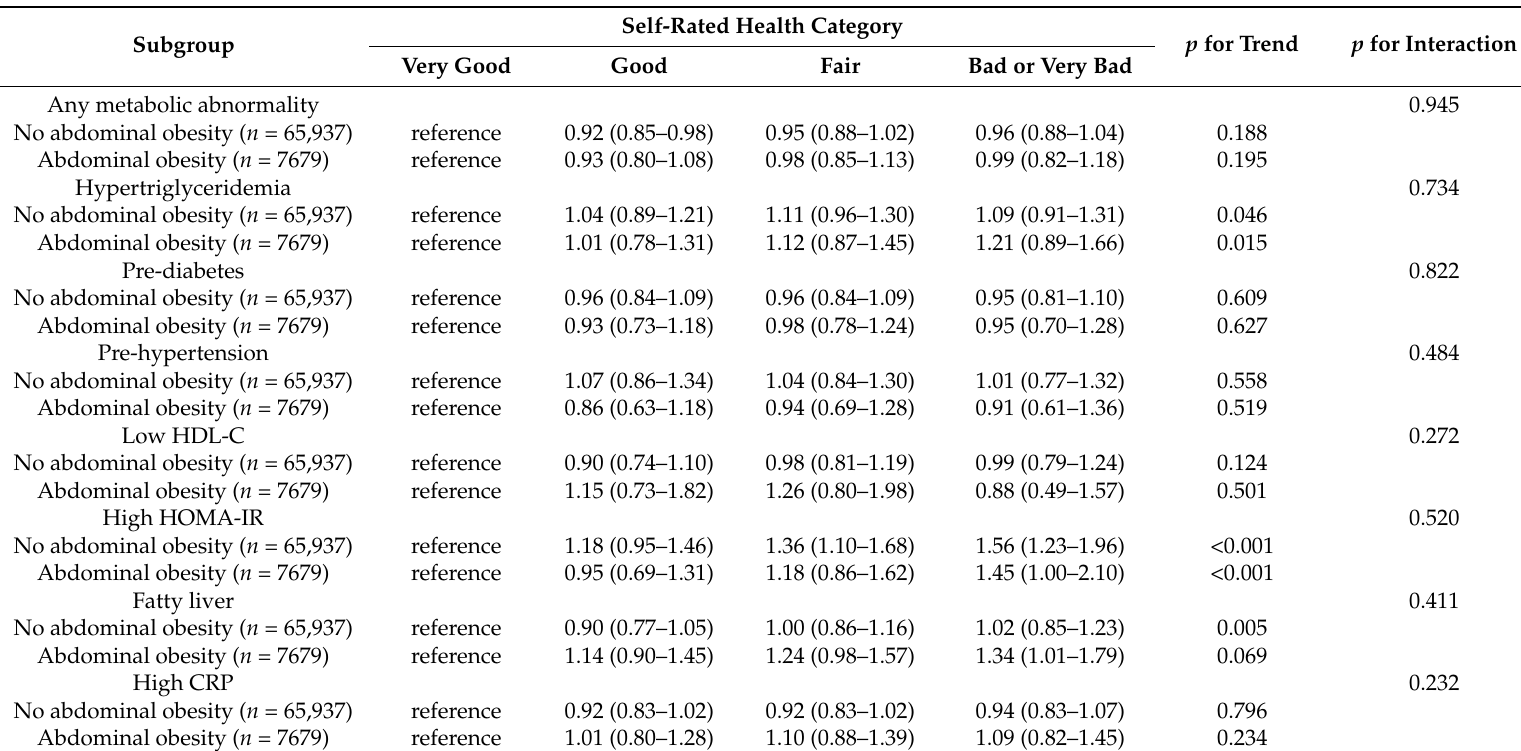
Table A3. Hazard ratios (95% CI) a of development of each metabolic abnormality according to self-rated health category stratified by abdominal obesity ( n =